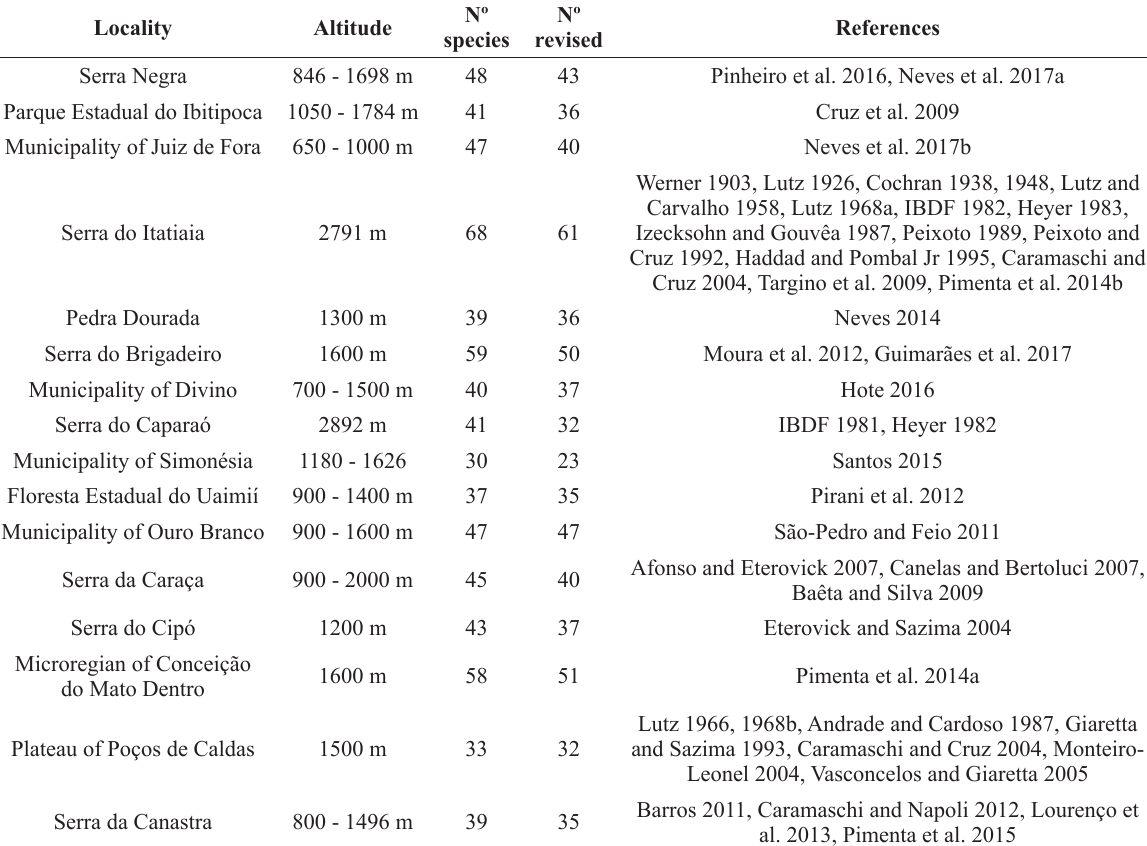
Areas used in the analysis with varying altitudes, Number of species recorded, Corrected number of species used, and their